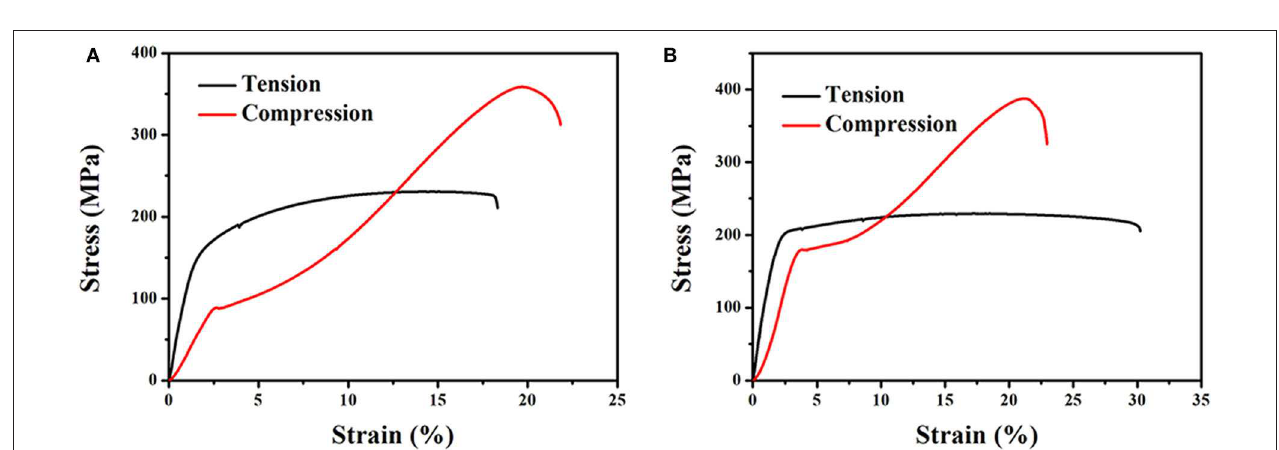
FIGURE 6 | Stress–strain curves of (A) as-extruded Mg − 1Sn alloys and (B) as-extruded Mg − 1Sn − 0.1Ti alloys.